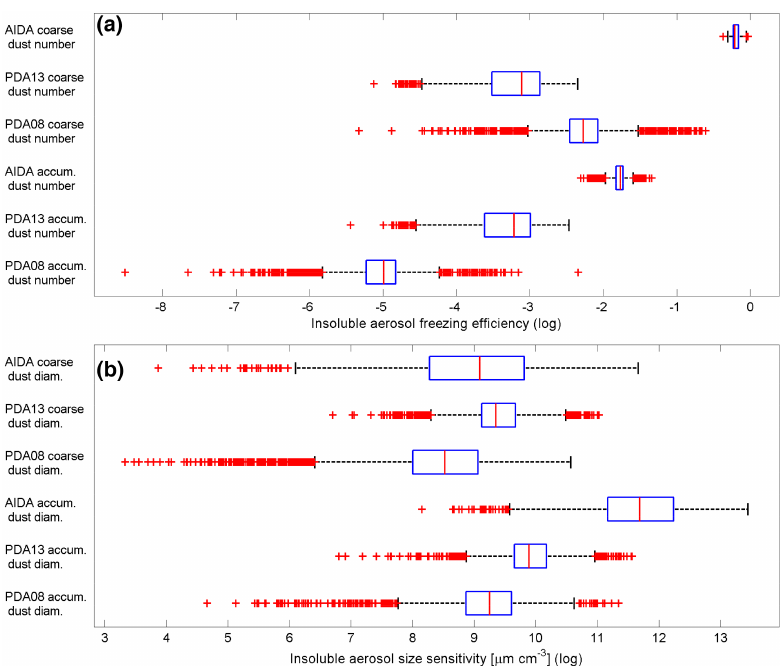
Figure 7. Log-space distributions of a random sampling of (a) accumulation- and coarse-mode dust number and (b) dust diameter for PDA08, PDA13 and AIDA spectra during purely heterogeneous nucleation. The box is constructed with 25th percentile, q 1 ; median, q 2 ; and 75th percentile, q 3 . Outlying points are marked with crosses if they fall outside [ q 1 − 1 . 5 (q 3 − q 1 ),q 3 + 1 . 5 (q 3 − q 1 )